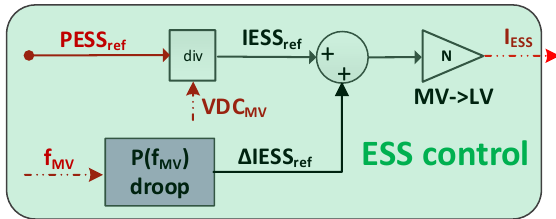
Figure 14. P ( f MV ) droop controller incorporated in the controller of the MV inverter (shown in